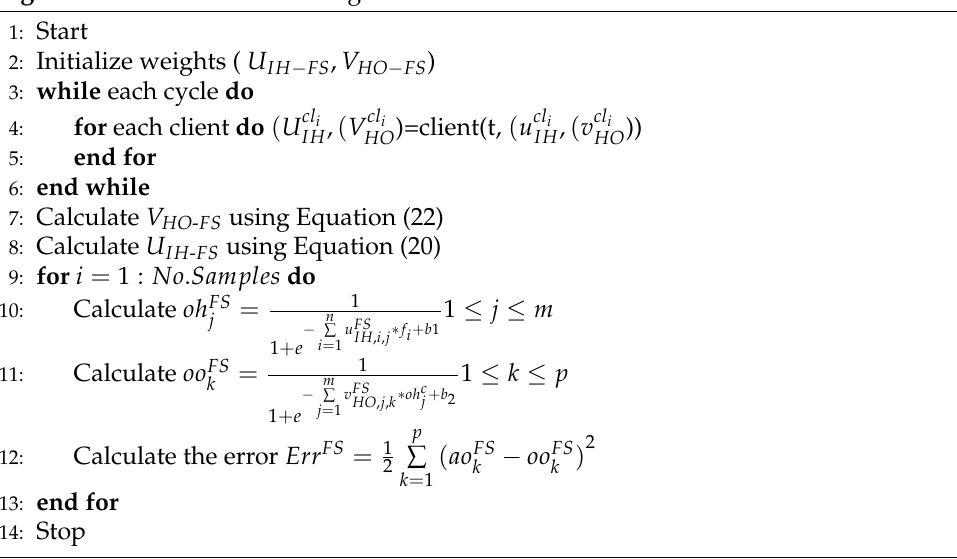
Algorithm 2 Federated server